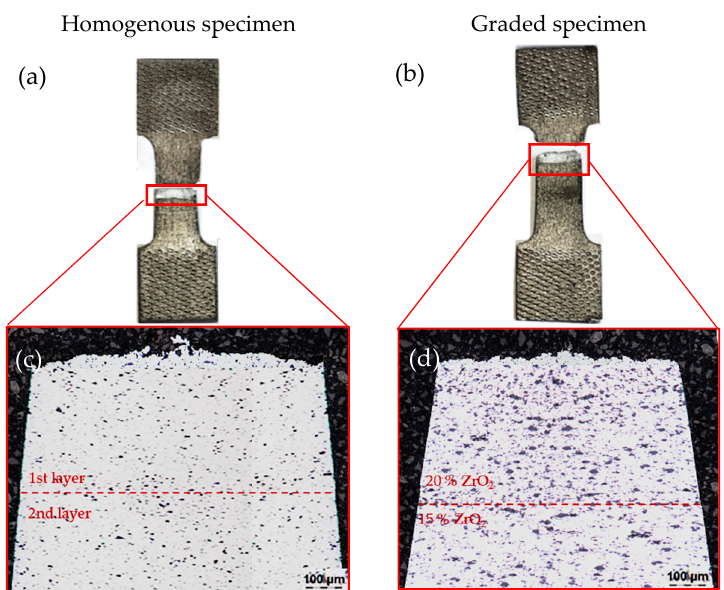
Figure 10. Tensile test specimens with ( a ) homogeneous and ( b ) graded particle distributions and ( c ) and ( d ) light microscopy images of their meridian sections.